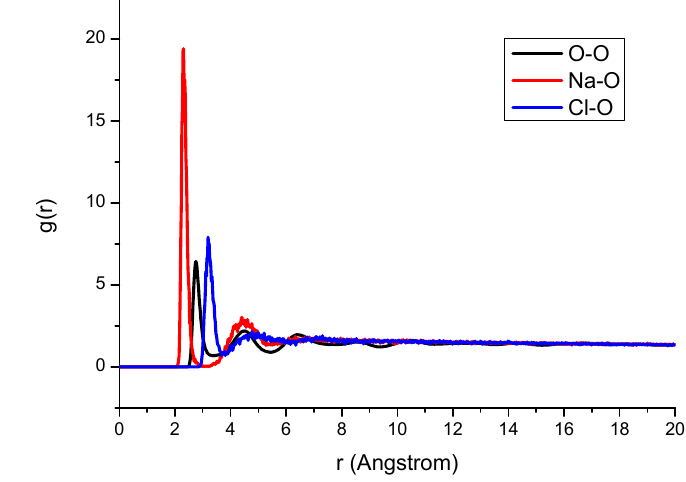
Figure 7. Radial distribution functions for Na + , Cl − , and oxygen atom.